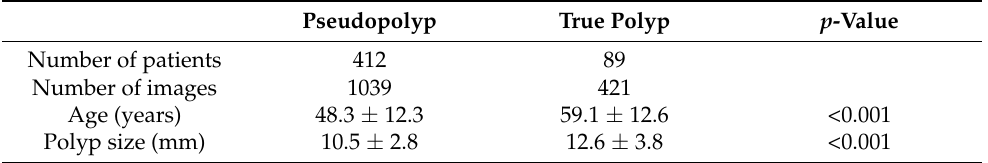
Table 1. Specifications of study dataset. We compared the pseudopolyp and true polyp groups using Student’s t